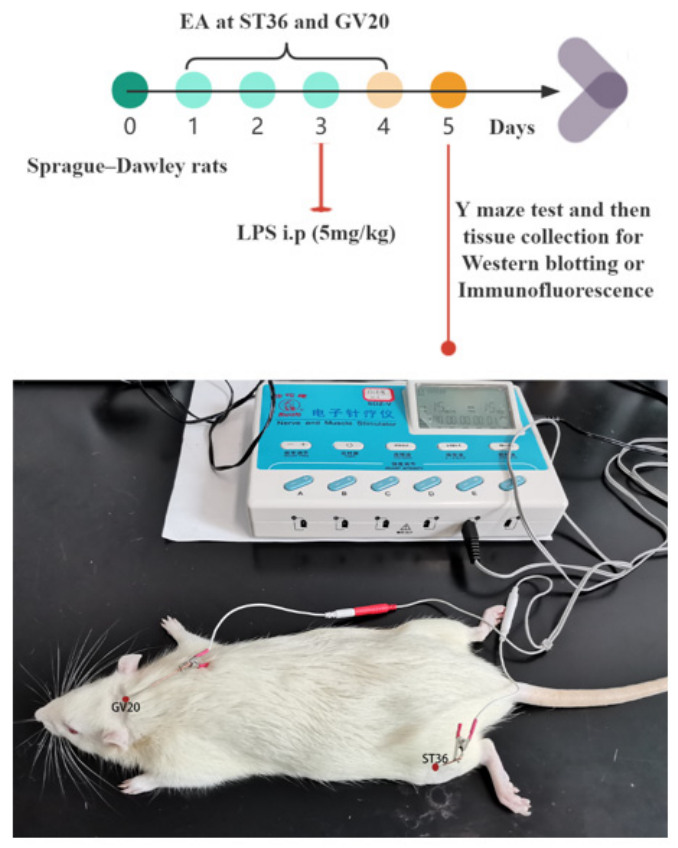
Figure 1. Experimental design and EA diagram. EA treatment was given at 15 Hz and an intensity of 1 mA for 20 min once a day from day 1 to day 4. Abbreviations: EA, electroacupuncture; LPS, lipopolysaccharide; GV20, Baihui; ST36, Zusanli; i.p., intraperitoneal